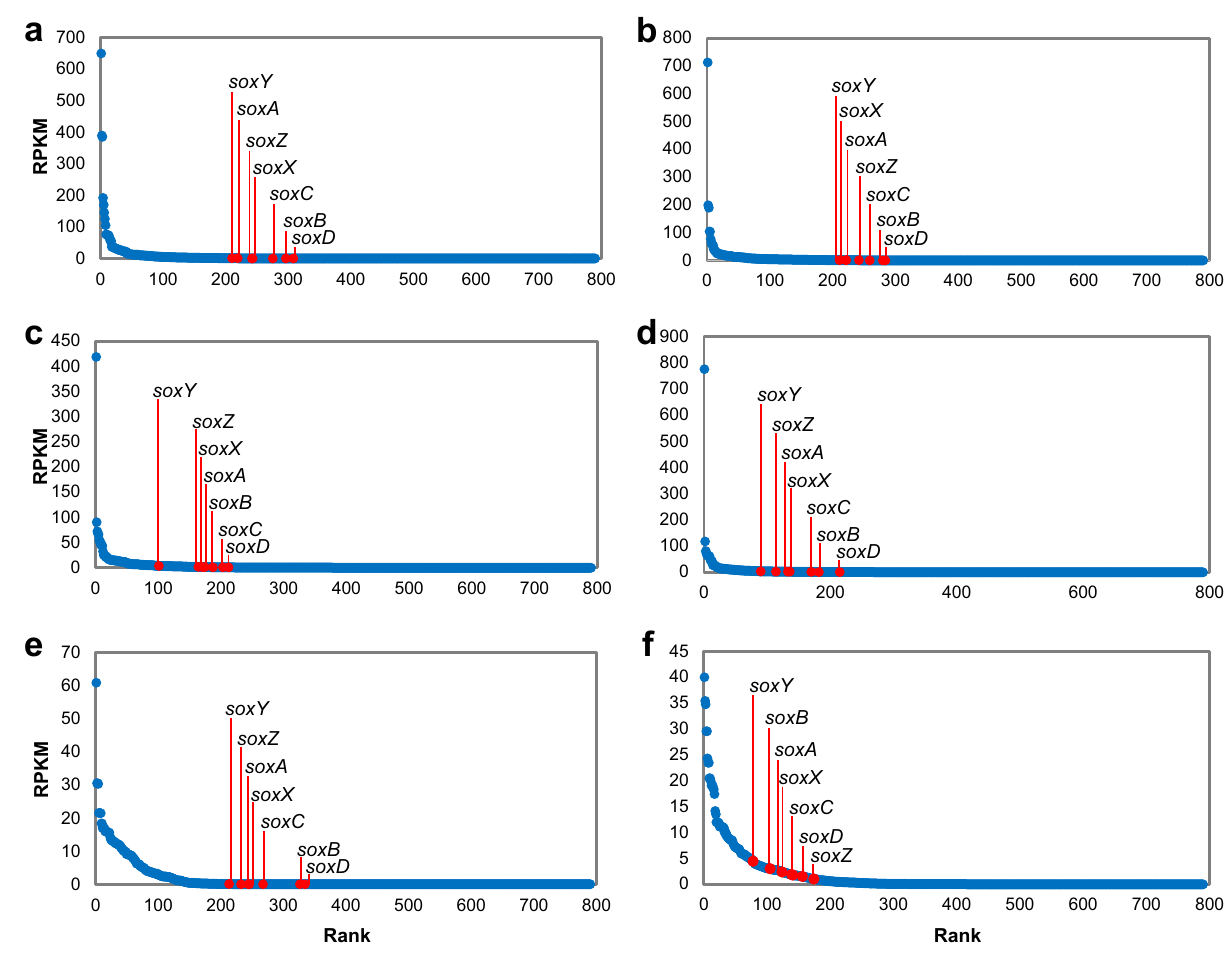
Fig. 3 | Expression of sox genes in the six bio fi lm metatranscriptomes. The bio fi lms were collected in Sep 2020 ( a ), Nov 2020 ( b ), Jan 2021 ( c ), Mar 2021 ( d ), May 2021 ( e ), and Jul 2021 ( f ). Genes were predicted from assembled metatran- scriptomes and annotated by KEGG. Rank analyses of the seven sox genes among